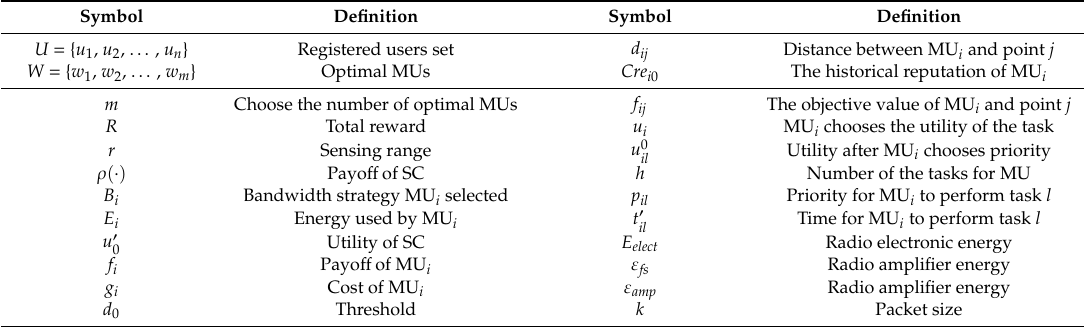
Table 1. Definitions of